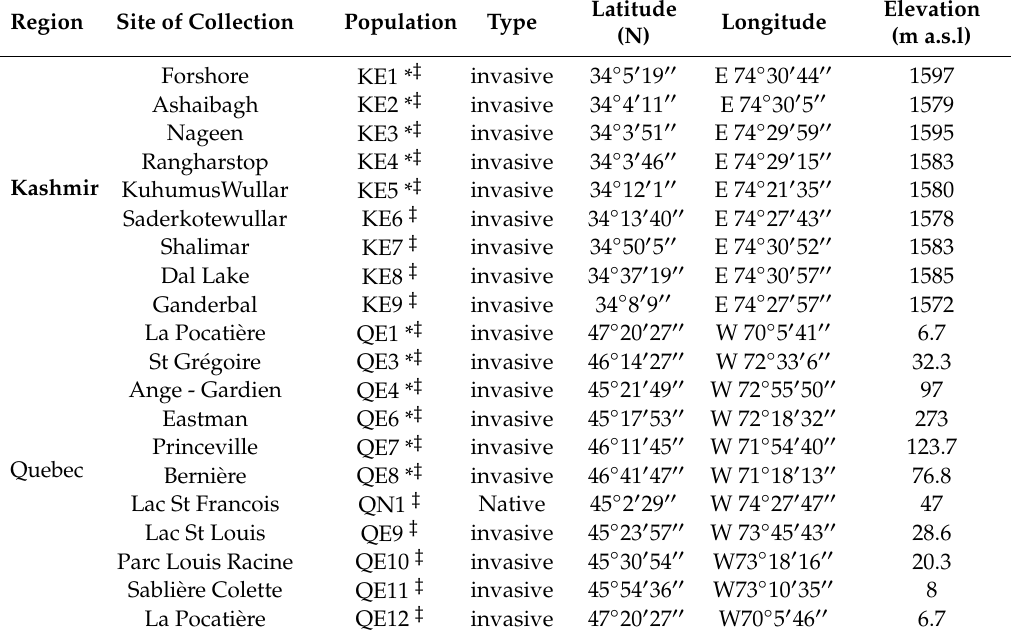
Table 6. Geographic locations of Phragmites australis populations that were sampled in a study assessing and comparing the phenotypic and genetic diversity of the species in Quebec and Kashmir (India) with their putative population type as identified by morphometric characters (KE: alien invasive haplotype from Kashmir (India); QE: alien invasive haplotype from Quebec (Canada); QN1: native haplotype from Quebec; * populations that were sampled for phenotypic study; ‡ : populations that were sampled for genotypic study; a.s.l = above sea level).